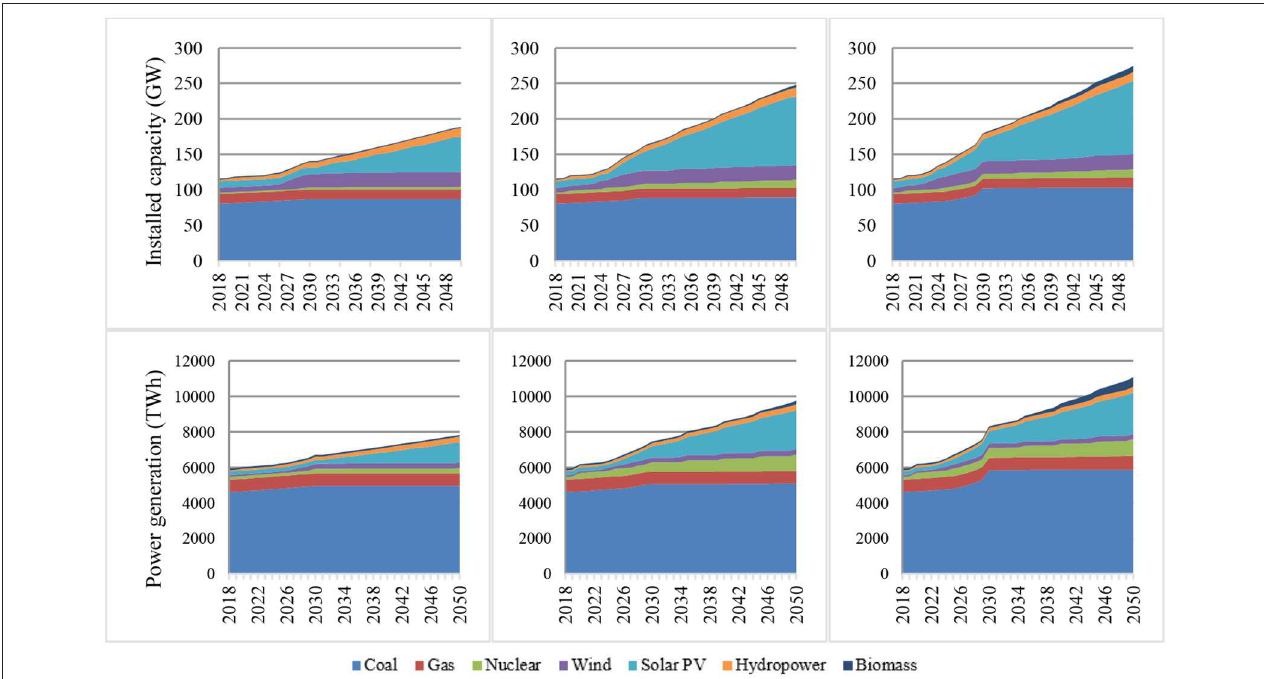
FIGURE 2 | Installed capacity and power generation in different demand scenarios (from left to right: LD, REF, and HD scenarios).